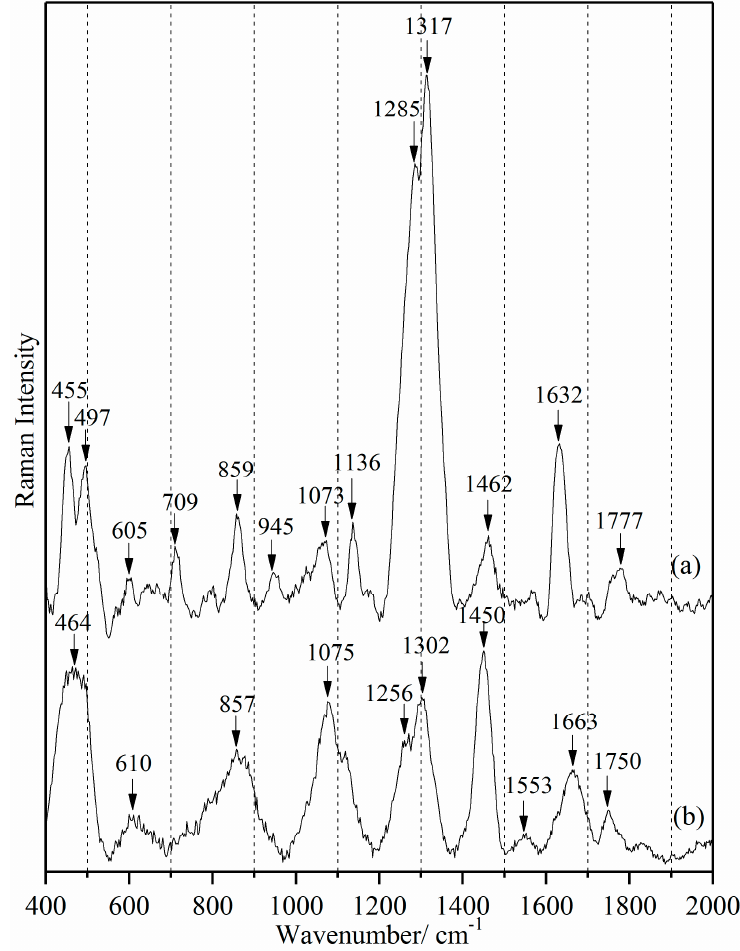
Figure 2. Raman spectra of tetracycline hydrochloride powder ( a ) and whole milk ( b ).